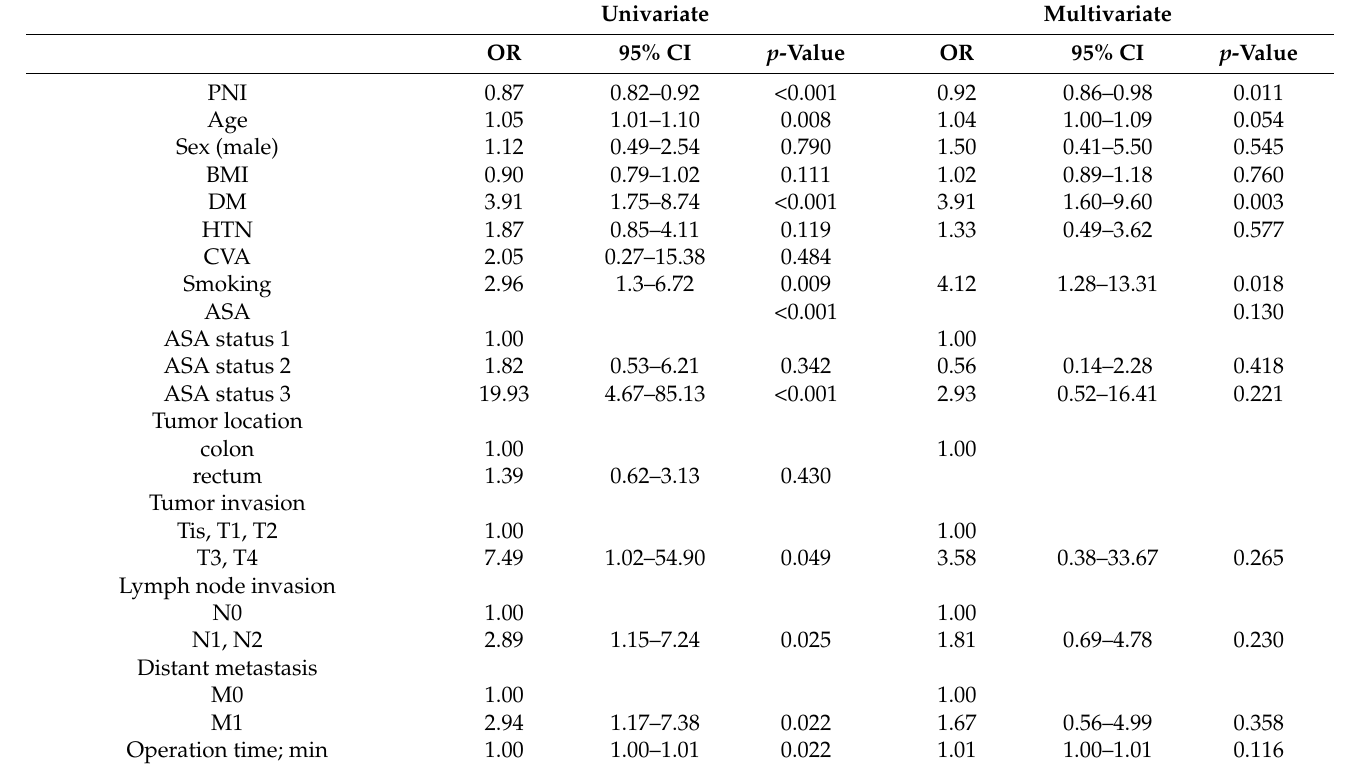
Table 3. Univariate and multivariate logistic regression analysis of 1-year